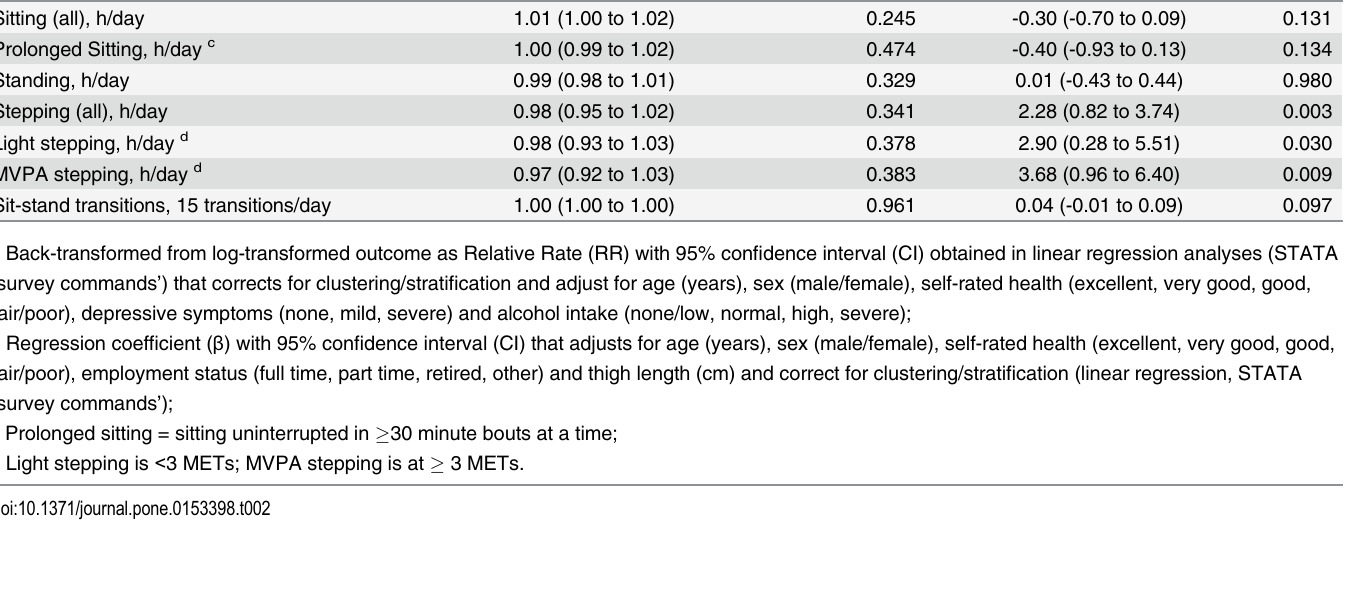
Table 2. Association of activPAL3 ™ derived activities with the 8ft Timed Up and Go (TUG-8) and Knee Extensor Strength (KES) test in Australian adults aged 36 – 80 years. TUG-8 completion time (seconds) RR (95% CI)